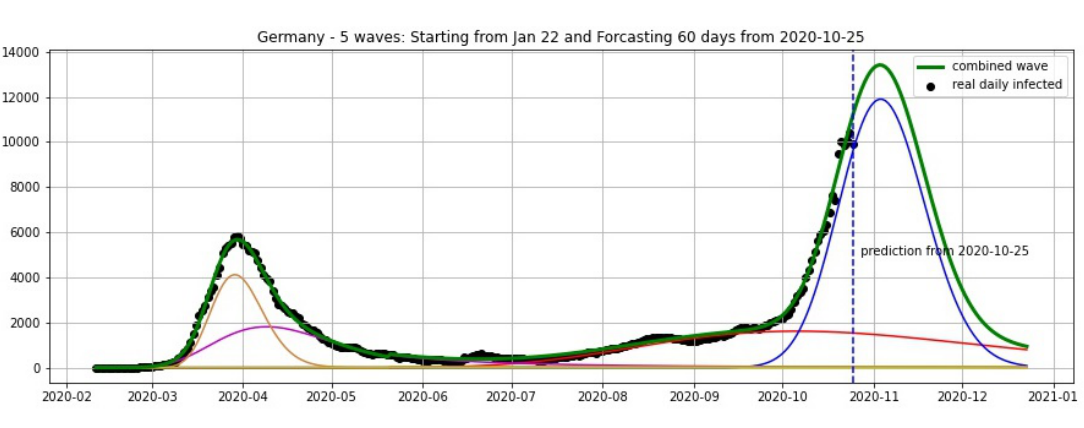
Figure 7. France: fitting and forecasting from 26/09 with 5 wavelets. The green curve is the combination of other curves which are EF wavelets.